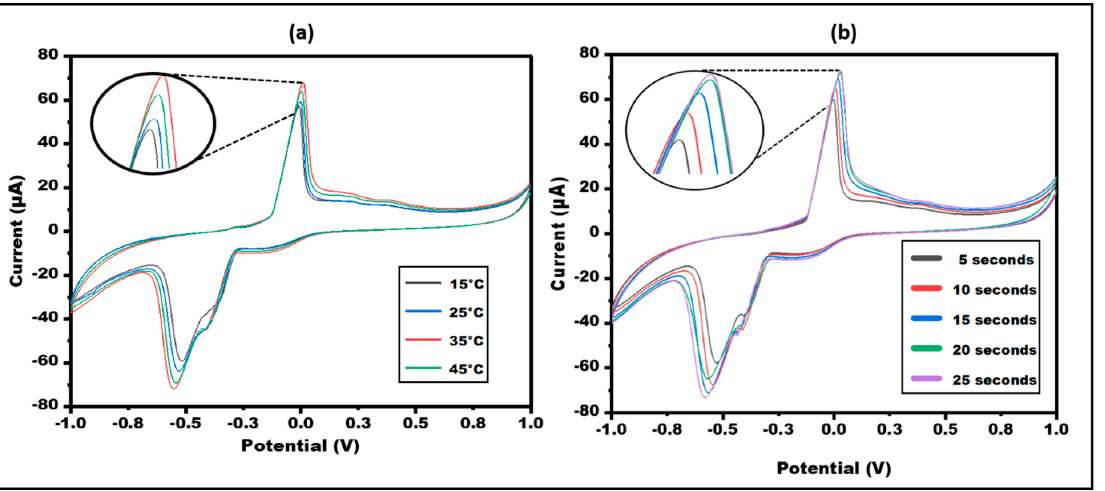
Figure 6. Cyclic voltammetry obtained at Bilirubin/Bilirubin oxidase/Ag NPs paper-based sensor for different ( a ) Temperature (15-45 °C) ( b ) Time (5-25 s) in 10 mM Ferro-Ferri in PBS at 50 mVs − 1 .